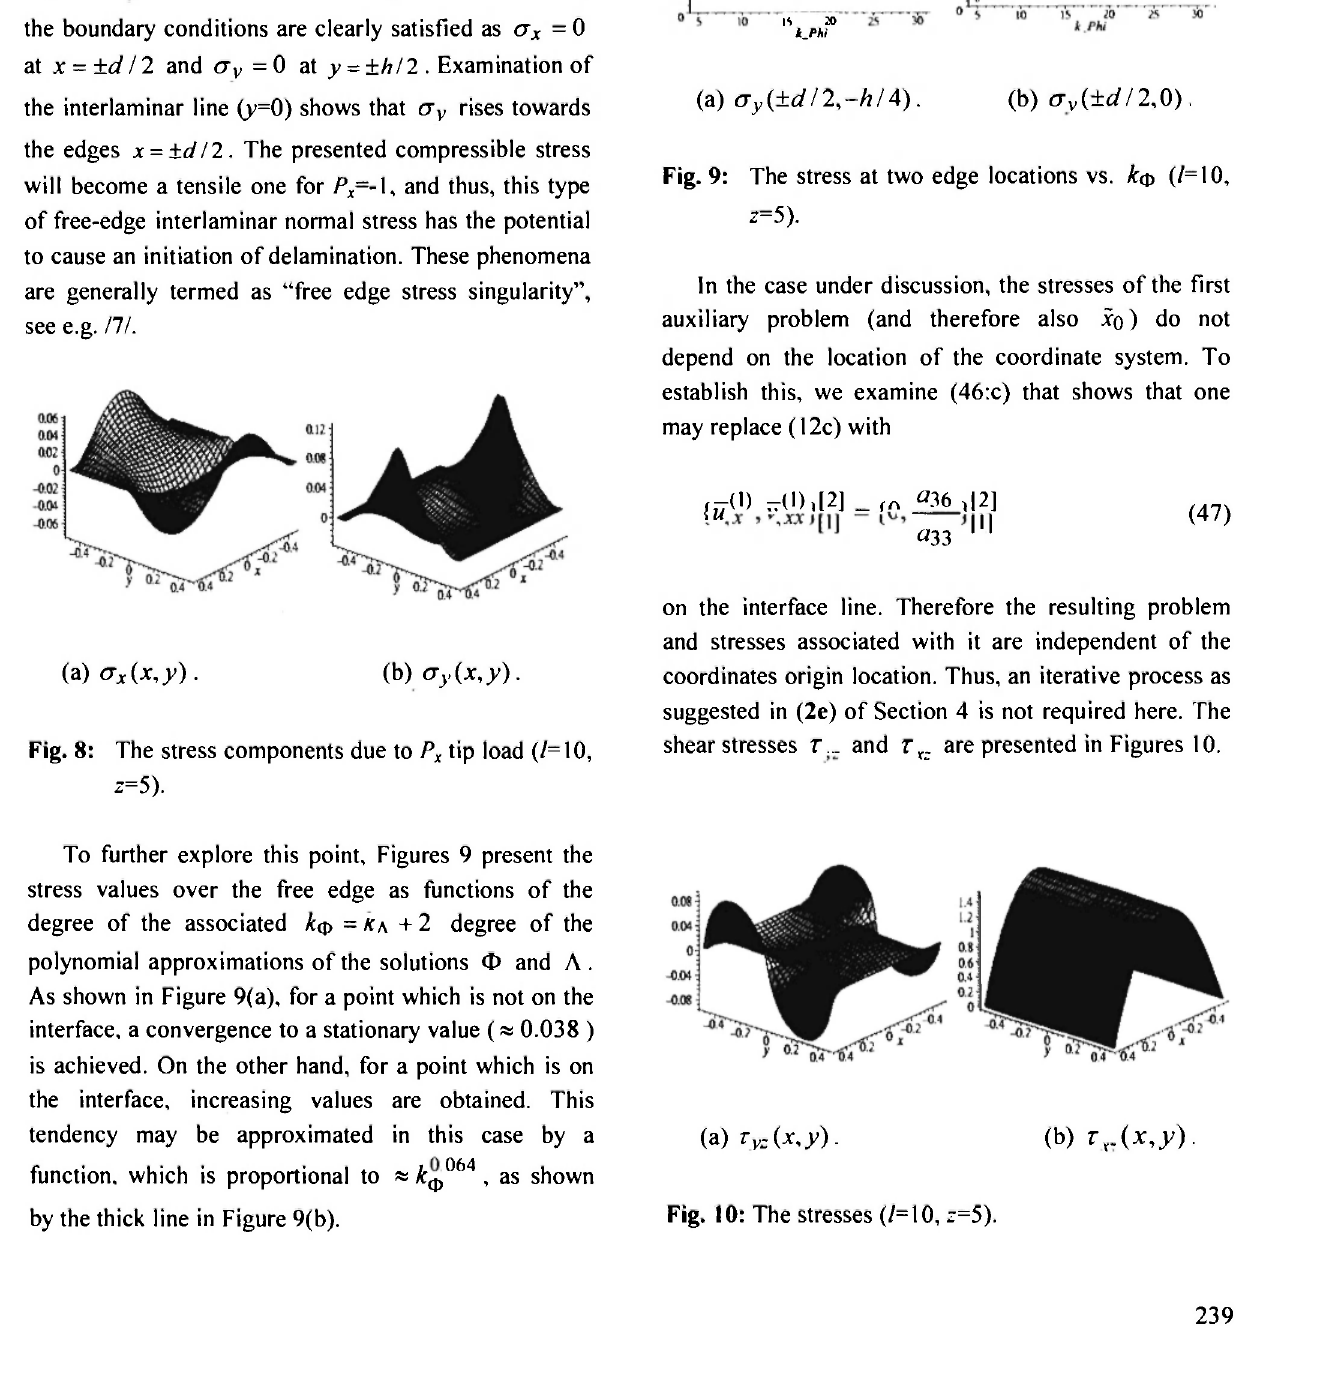
Fig. 10: The stresses (/= 10,